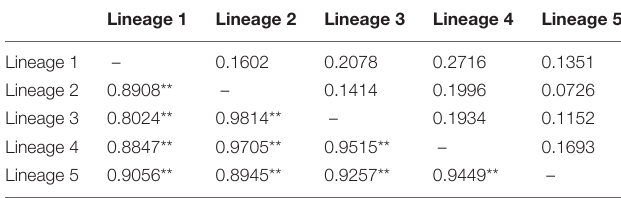
TABLE 3 | Genetic differentiation ( F st , below diagonal) and Nei’s genetic distance (above diagonal) among five genetic lineages of Agarophyton vermiculophyllum in the native northwest